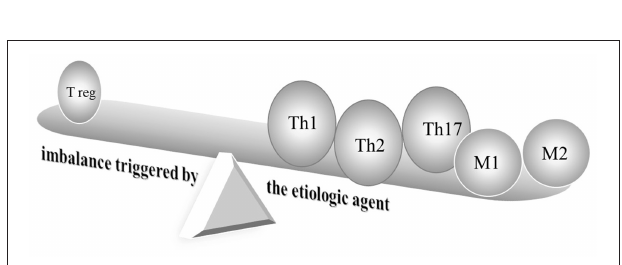
FIGURE 2 | Schematic diagram of immune responses in Kawasaki disease. Cutting-edge research has indicated the deterioration of T helper type (Th)1, Th2, Th17, and regulatory T cells, as well as activated and alternatively activated macrophages in KD. M, macrophage; reg, regulatory; Th,